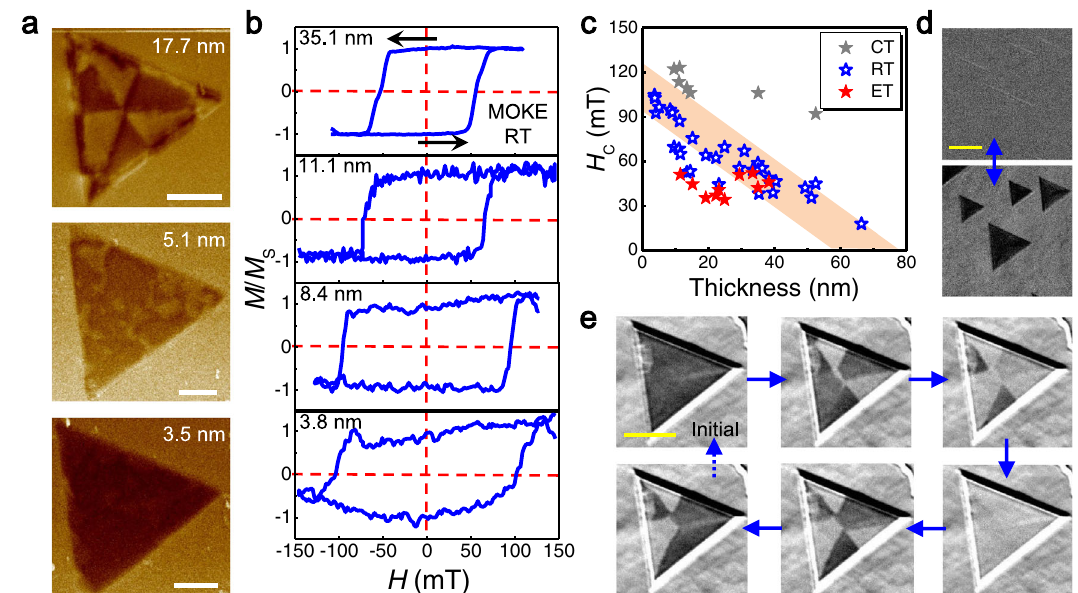
Fig. 4 | Thickness-dependent magnetic properties of CFO nanosheets. a MFM phase images of CFO nanosheets with variable thicknesses measured at room temperature (RT, 300K). Scale bars: 3 μ m. b MOKE hysteresis loops of CFO nanosheets with variable thicknesses measured at RT under OOP magnetic fi eld. Sweep directions are indicated by arrows. c The plot of H C versus the thickness of CFO nanosheets at cryogenic temperature (CT, 80K), RT, and elevated